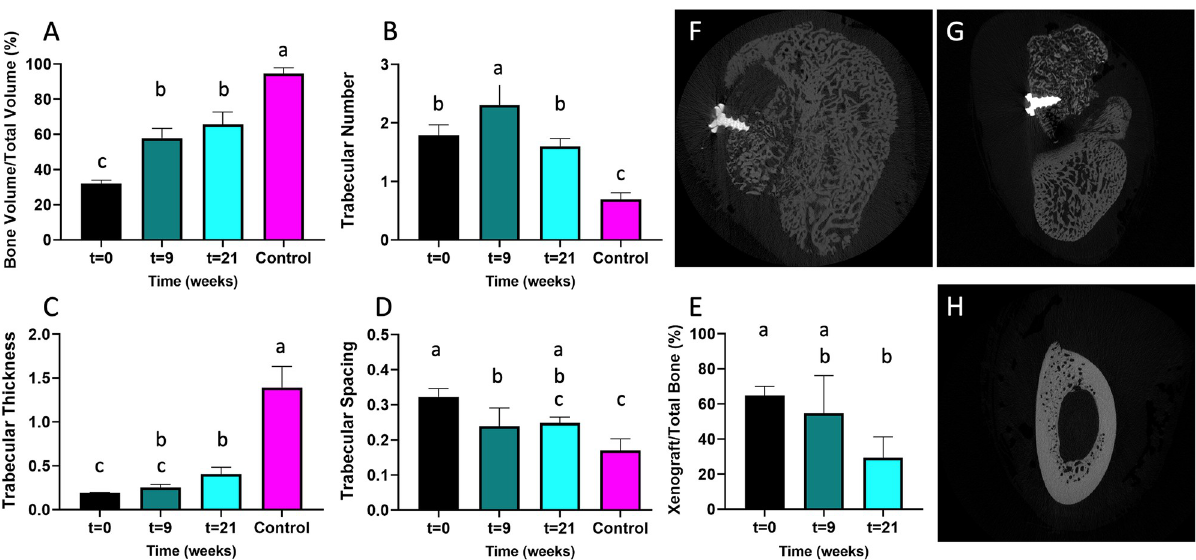
Fig 6. Remodeling of tissues with time. MicroCT was utilized to measure the BV/TV (A), TbN (B), TbTh (C), and TbSp (D) over time, with the t = 0 representing bioreactors pre-implantation (n = 6), t = 9 the bioreactors at the transfer surgery (n = 12), t = 21 the mandibles of the sheep who successfully completed the study (n = 3), and the control representing the contralateral unoperated mandible (n = 4). Image analysis was utilized to determine the proportion of xenograft with time (E). Representative radiographic cross-sections show modest osseointegration of the transferred bioreactor tissue (F) or good hardware integration but poor integration with adjacent bone (G), and the contralateral control mandible (H). Those that do not share the same letter are significantly different (p < 0.05).